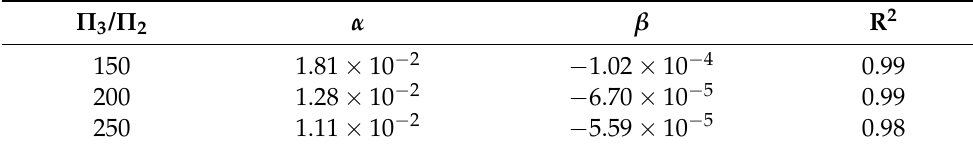
Table 3. Coefficients relating Π 0 to Π 1 .